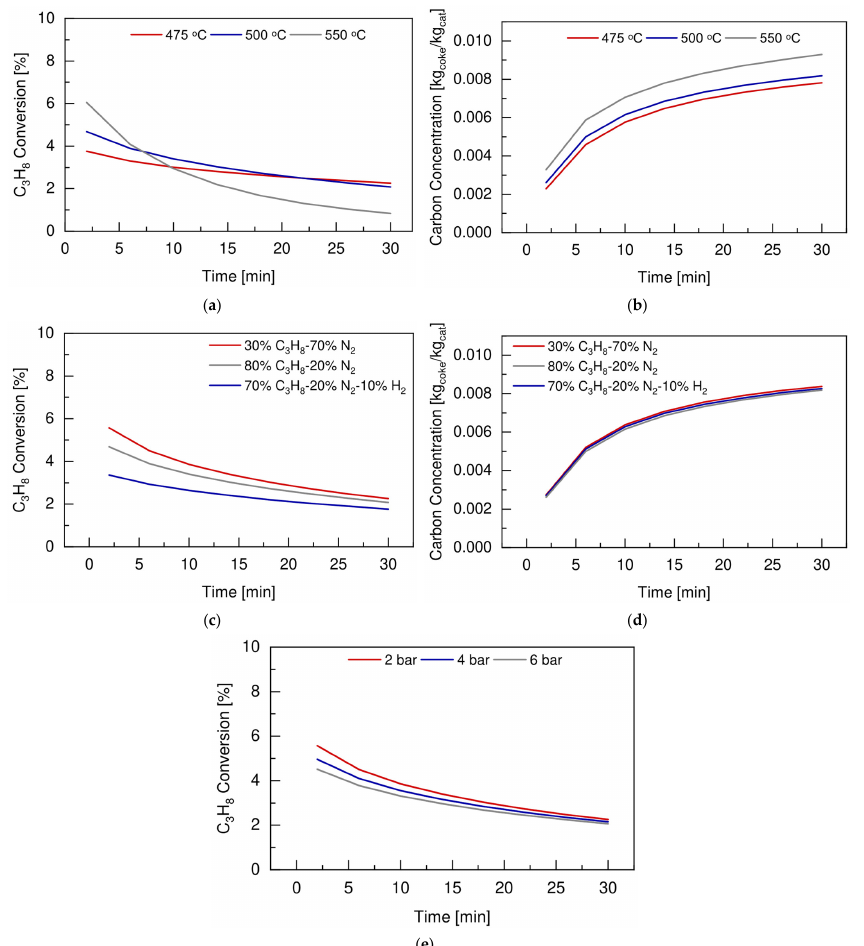
Figure 5. Effect of reaction temperature on ( a ) propane conversion and ( b ) carbon concentration, at 2 bar, u/u m f = 3.75 and feed composition of 80vol%C 3 H 8 and 20vol%N 2 . Effect of feed composition on ( c ) propane conversion and ( d ) carbon concentration, at 500 °C, 2 bar, u/u mf = 3.75. Effect of operating pressure ( e ) on propane conversion, at 500 °C, u/u mf = 3.75 and feed composition of 30vol%C 3 H 8 and 70vol%N 2 .